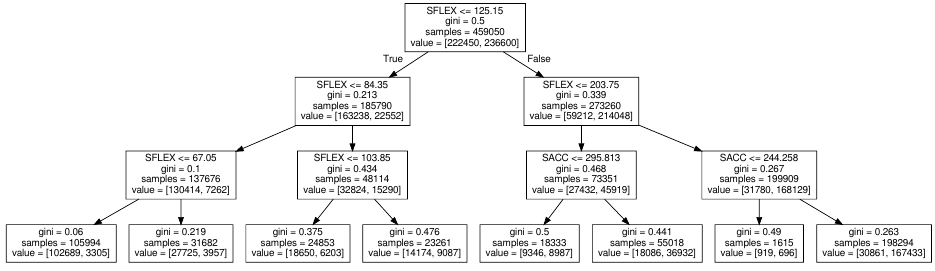
Figure 6. Decision tree that is used on the device to categorize the session. “Gini” means the Gini criterion split quality